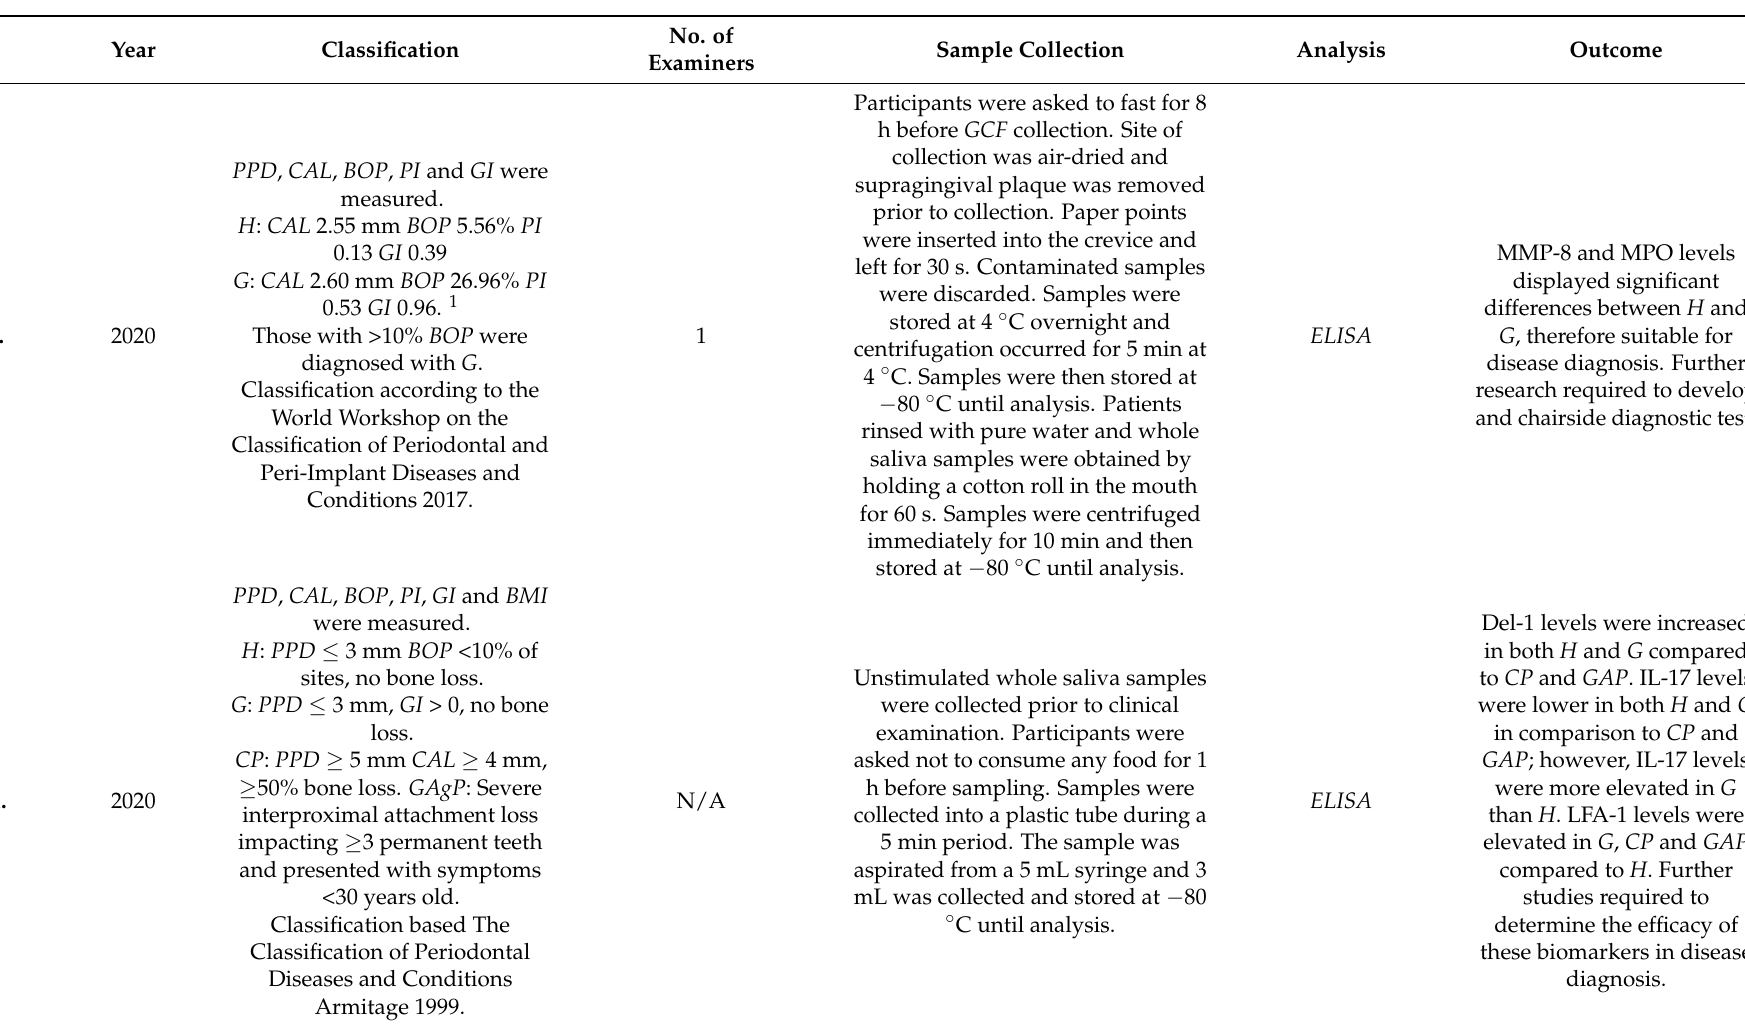
Table 9. Disease classification, number of examiners, sample collection method, sample analysis technique and brief outcome of studies analyzing inflammatory